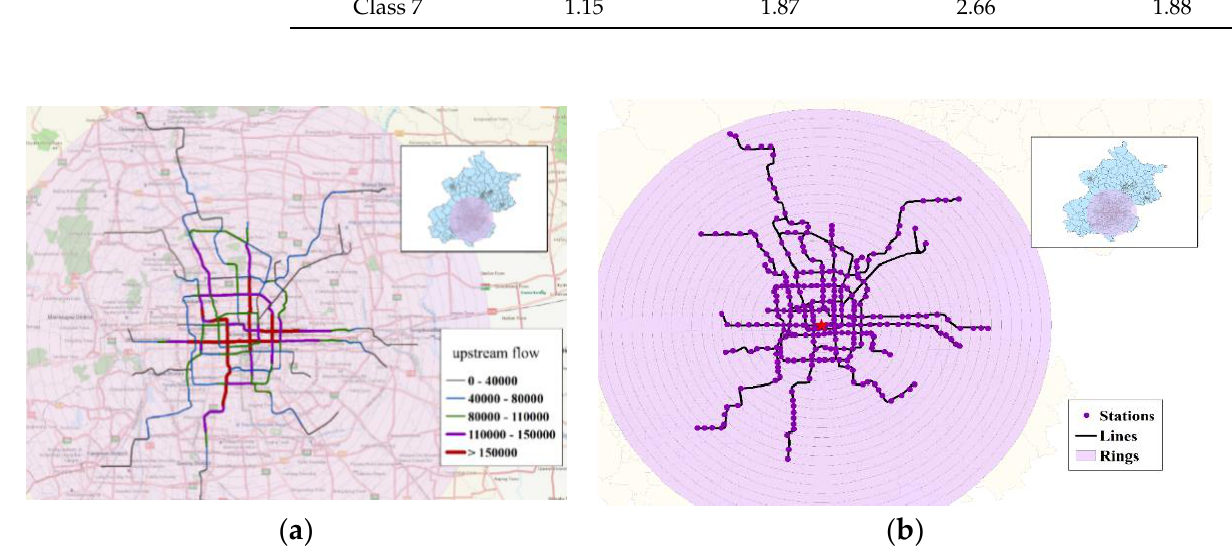
Figure 4. ( a ) Upstream flow in 2016 and ( b ) fractal units.